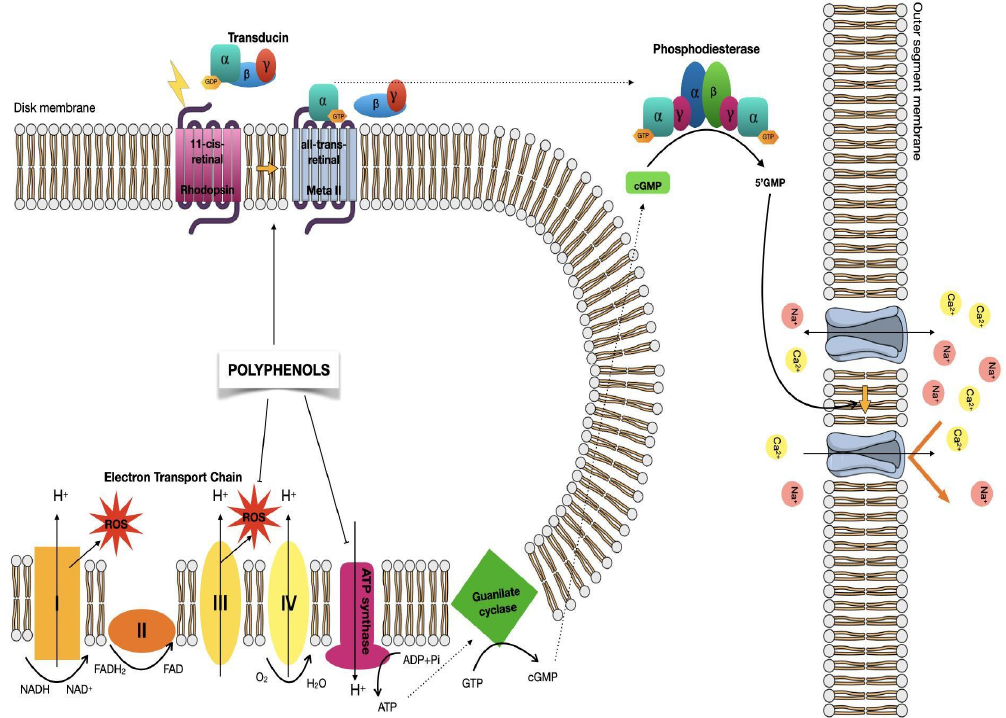
Figure 2. Visual phototransduction. Rho activates light causing isomerization of 11CR to ATR. The active form of Rho (meta II) interacts with Gt (composed of the α , β , and γ subunits) activating it and causing the exchange of GDP for GTP and the dissociation of the α subunit. This, in turn, activates cyclic guanosine monophosphate phosphodiesterase (cGMP), promoting the hydrolysis of cGMP and its conversion to 5 (cid:48) -GMP. Reduction in cytoplasmic cGMP concentration leads to closure of transmembrane channels by blocking the internal flow of Na + and Ca 2+ and leading to the hyperpolarization of the cell [62,64,65]. The electron transport chain and the ATP synthase present in the rod photoreceptors disks produce energy needed for the process, this energy production results in the production of reactive oxygen species (ROS) which can lead to cell damage. [67]. Polyphenols can act in different ways at the cellular level, they seem to be able to stabilize mutated Rho, can inhibit the ATP synthase or help prevent the ROS damage with their antioxidative